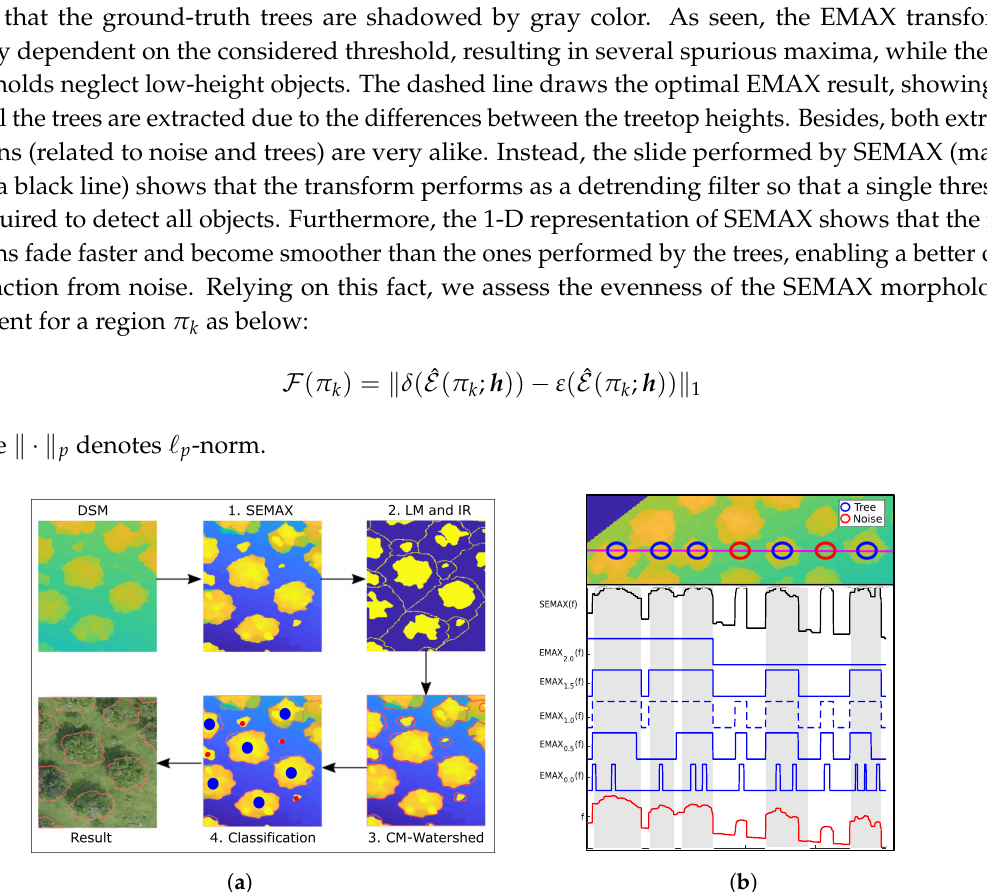
Figure 2. Framework of the proposed Cumulative Summation of Extended Maxima transform (SEMAX) methodology for automatic tree detection. ( a ) Pipeline of processing stages; ( b ) 1-D representation of compared morphological